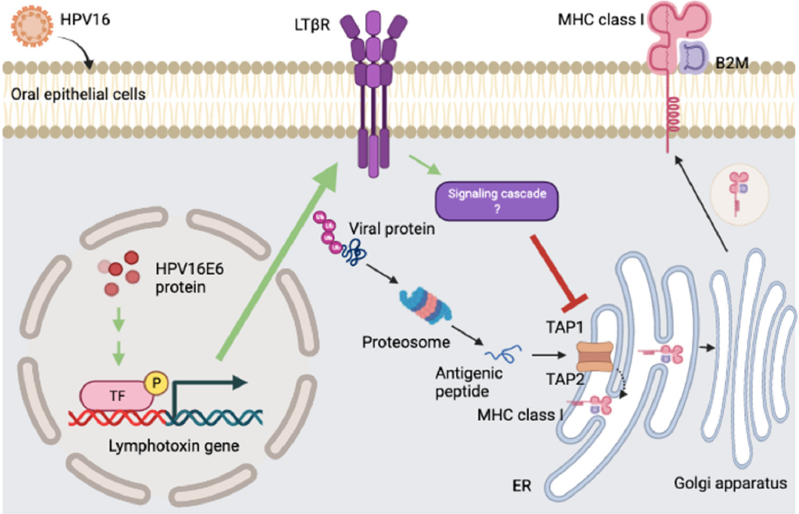
Figure 6. Proposed mechanisms of HPV16 E6 in oral carcinogenesis. HPV16 E6-activated LT is in- volved in TAP suppression in human oral cancer. HPV16 E6 upregulates lymphotoxin which func- tionally affects the stability of MHC-I by suppression of genes that are involved in MHC-I-depend- ent antigen presentation, TAP. Impaired T-cell responses could promote the persistent infection of HPV in oral cells, leading to oral cancer development and progression.